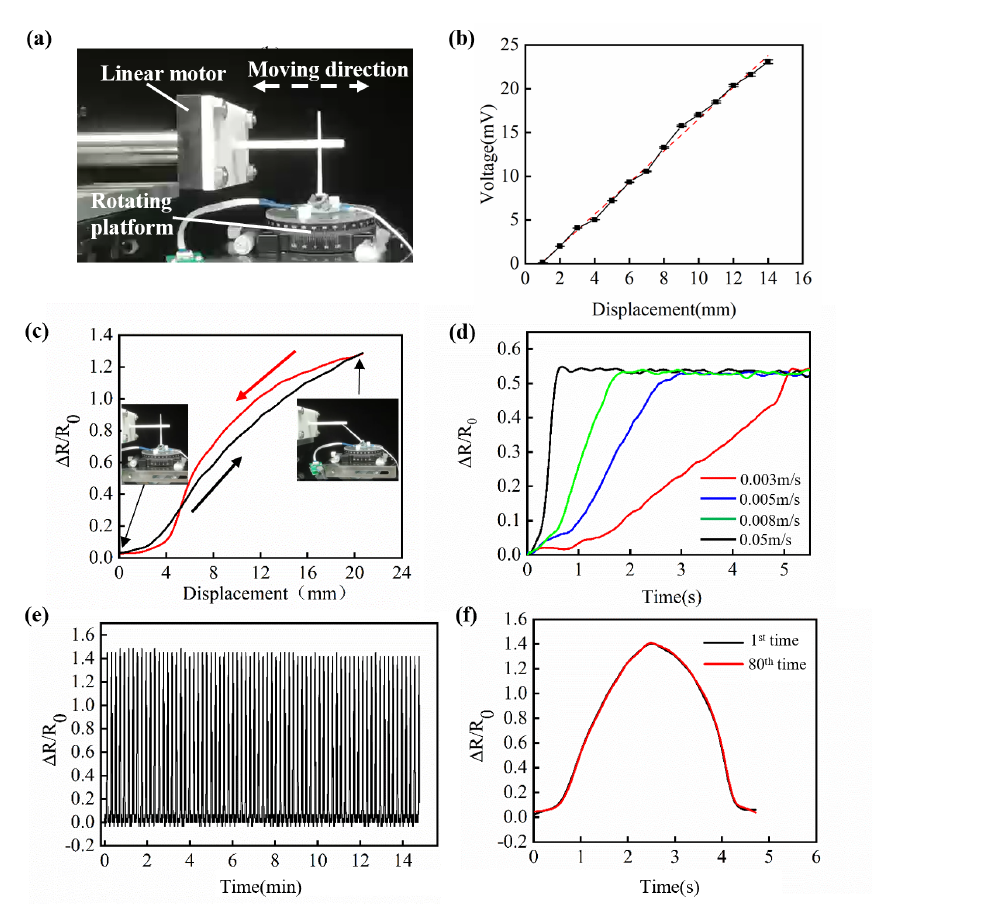
Figure 6. Sensor performance of the miniature soft sensor. ( a ) The experimental setup. ( b ) Linearity results from the sensor. ( c ) Sensor loading and unloading performance. The black line represents the sensor resistance for displacement from 0 to 22 mm, and the red line represents the sensor resistance for displacement from 22 to 0 mm. ( d ) Sensor dynamic response. Different color curves indicate the change of the sensor’s resistance value under different actuation speeds of the linear motor ( e ) A repeating test shows that the miniature soft sensor maintains high reliability after pushing and releasing 80 times. ( f ) Comparison of the first and the 80th resistance change